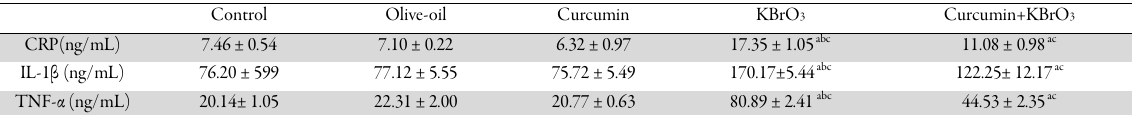
Table 2. Effects of curcumin on serum levels of CRP, and IL-1β and TNF-α in rats exposed to KBrO3